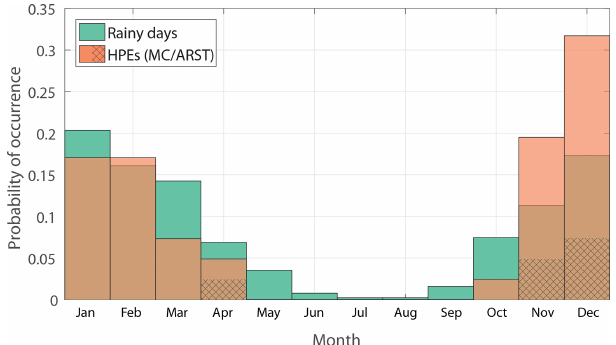
Figure 3. Monthly probability of occurrence of rainy days near the radar location (green; Bet Dagan rain gauge; 32.0 ◦ N, 34.8 ◦ E), and of HPEs from the radar archive (orange). Hatching represents HPEs classified as